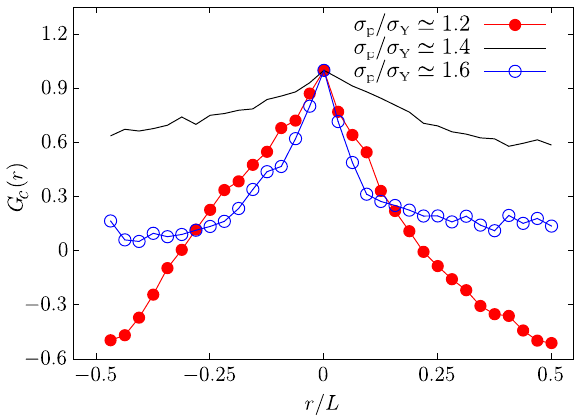
FIG. 9. Overlap-overlap connected correlation function [See Eq. (8) and text for details] for different values of peak stress σ p . It is possible to notice that the correlation function takes on the highest values on the entire domain for the ratio σ p = σ Y ≃ 1 . 4 corresponding to the bimodal behavior (see Fig. 6). The integral of G ð r Þ is usually known as dynamic heterogeneity